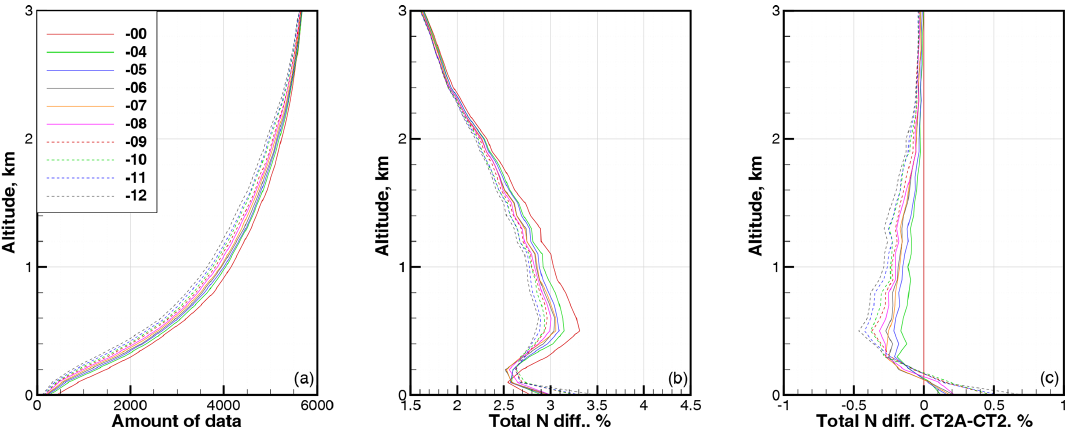
Figure 5. Statistics for latitude band 20–30 ◦ . (a) Amount of data. (b) RMS relative difference in refractivity COSMIC–ECMWF (cid:49)N CE . (c) RMS relative difference in refractivity CT2A–CT2. All are functions of the parameter β .